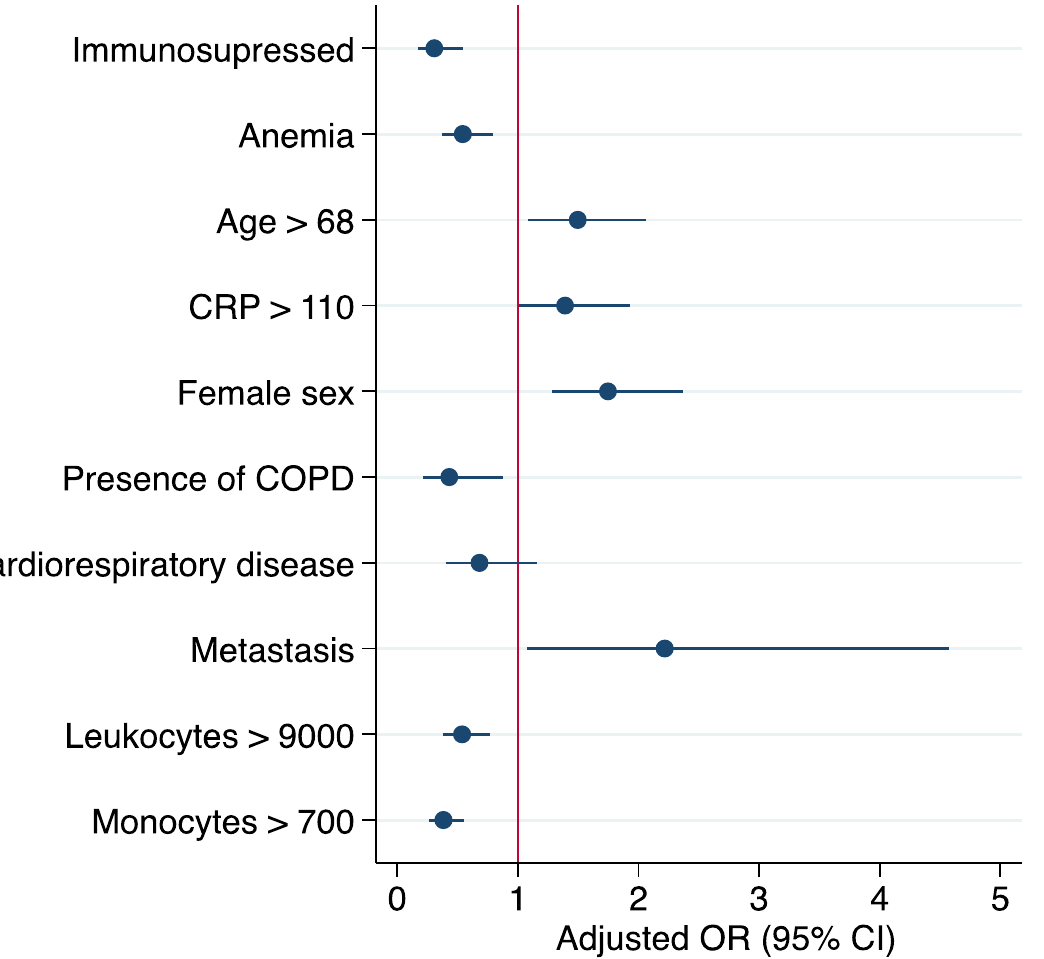
Figure 1. Forest plot of output from the logistic regression model evaluating odds for identifying patients with COVID-19. The circle represents odds ratio value on the X-axis. The error bars or whiskers ⊢ ⊣ represent the 95% CI of the odds ratio. The labels on the Y -axis represents the variables included in the logistic regression for the identification of patients with COVID-19. Age is expressed as years, C-reactive protein (CRP) as mg/L, leukocytes and monocytes levels as cells/ µ L. CRP: C-reactive protein; COPD: chronic obstructive pulmonary disease.